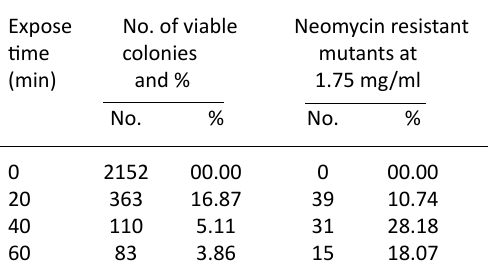
Table 2. Action of NTG on spores’ survival of S. albogriseolus NRRL B-1305